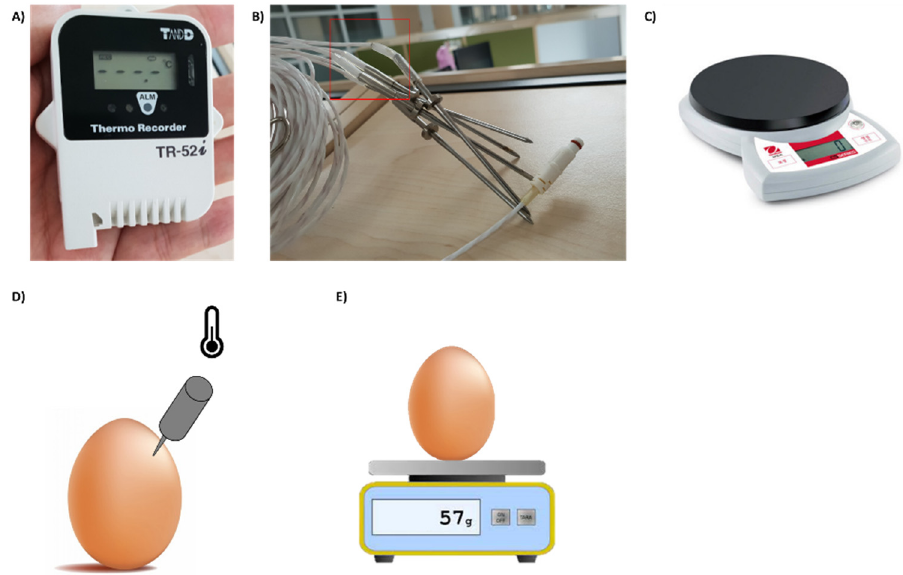
Figure 1. The apparatus for measuring temperature and weight of egg: ( a ) the temperature measurement device; ( b ) the temperature measurement tip; ( c ) the digital scale; ( d ) temperature measurement method; ( e ) egg weight loss measurement method.